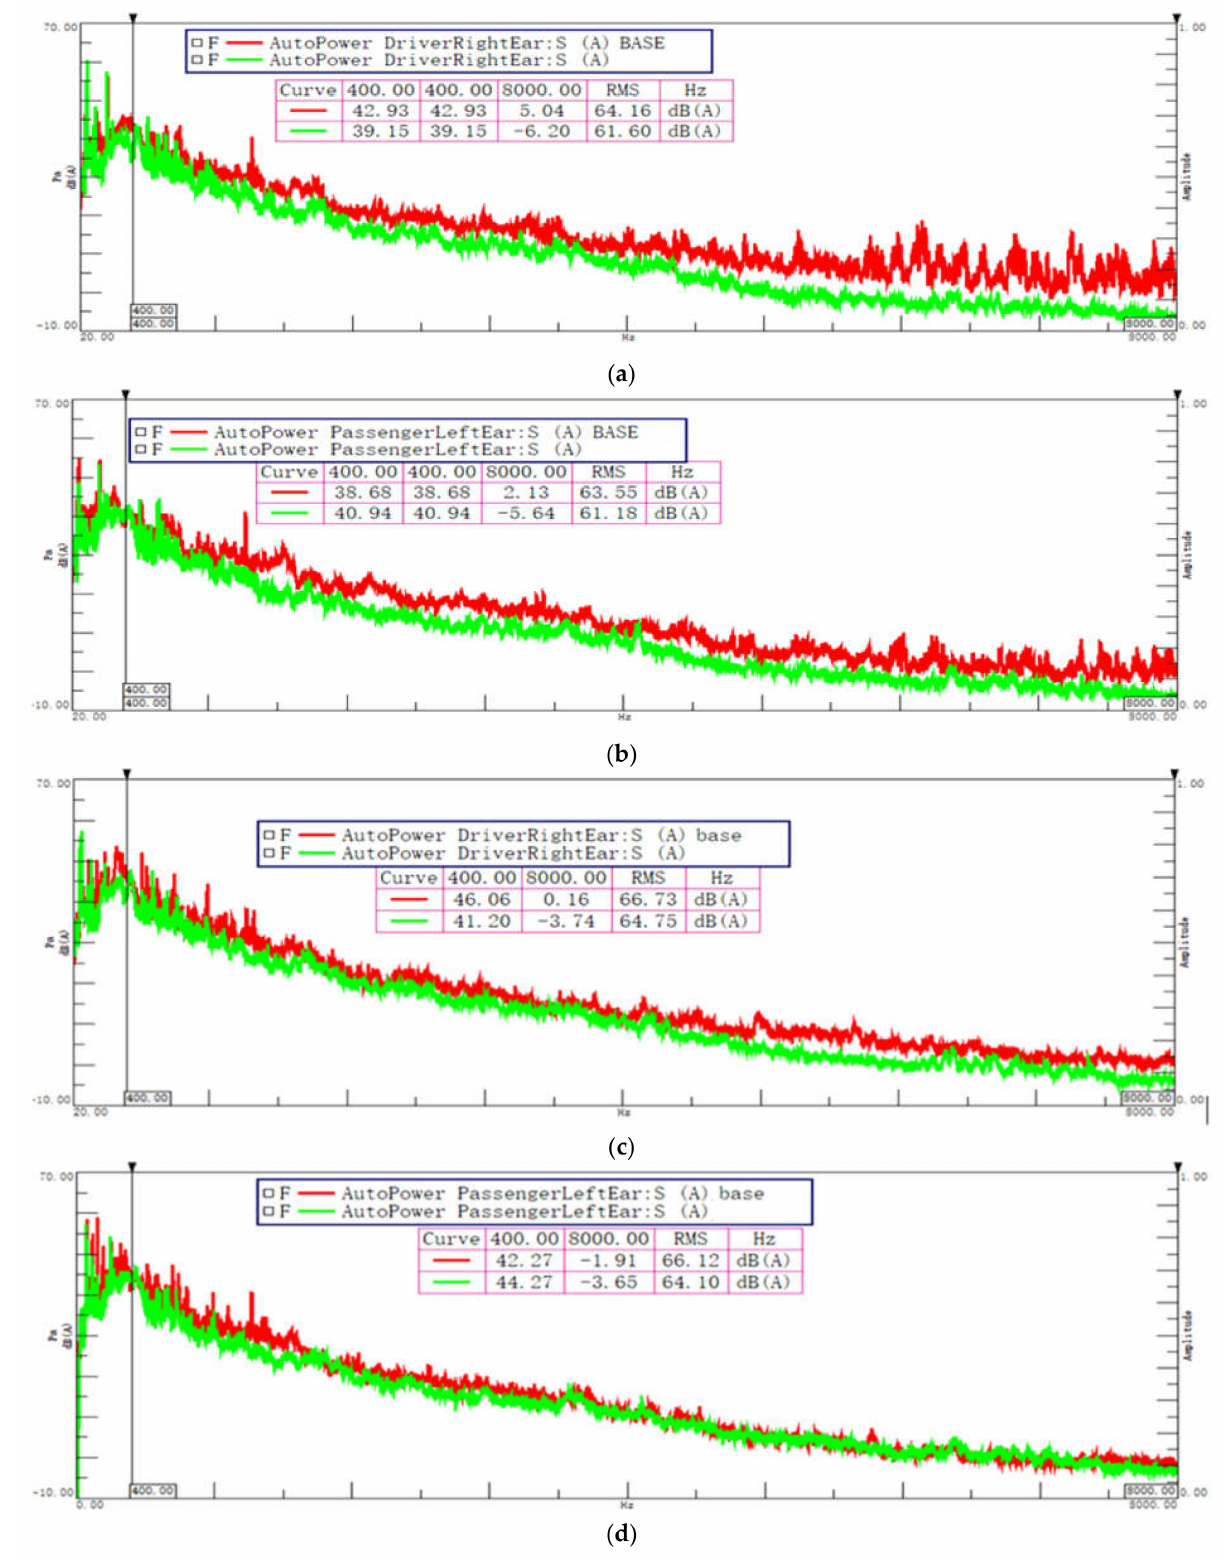
Figure 18. Optimization of acoustic performance under typical load conditions. ( a ) 70 km/h uniform full load condition, comparison before and after optimization of main drive noise; ( b ) 70 km/h uniform full load condition, comparison before and after optimization of first drive noise; ( c ) 80 km/h uniform full load condition, comparison before and after optimization of first drive noise; ( d ) 80 km/h uniform full load condition, comparison before and after optimization of first drive